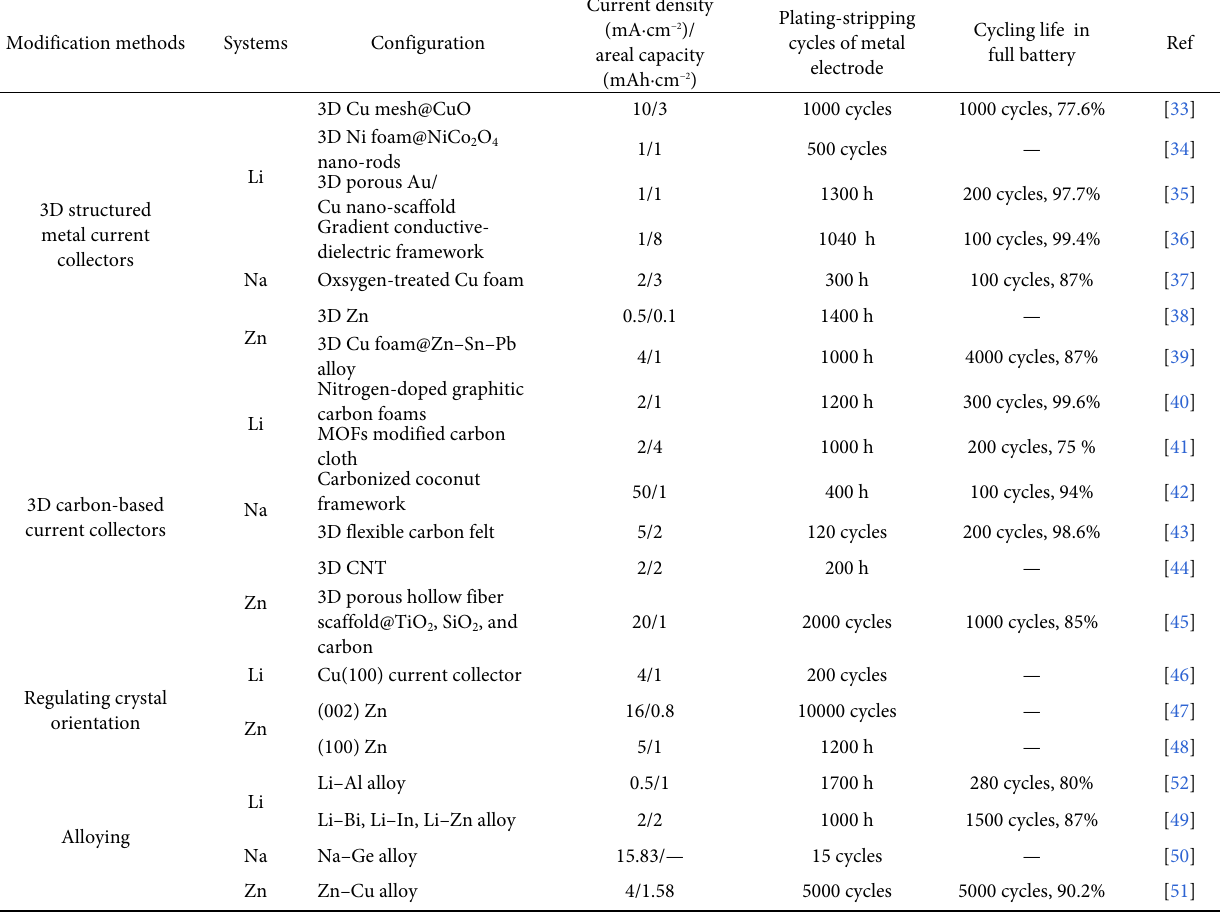
Table 1 Strategies in intrinsic transport dynamics optimization Modification